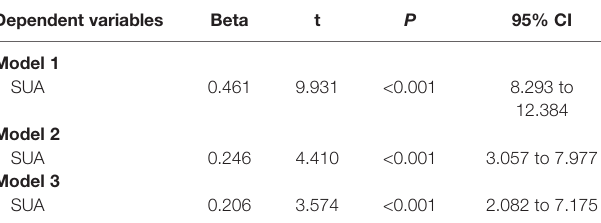
TABLE 4 | Multiple linear regression examining the association of BMI with SUA.